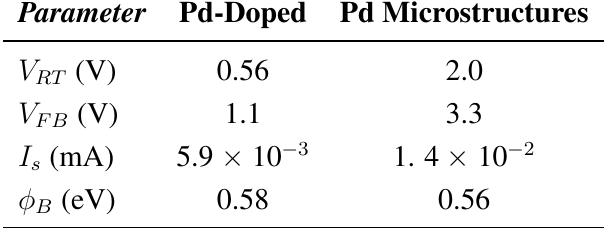
Table 2. Air-ambient, room temperature device characteristics of the MSM